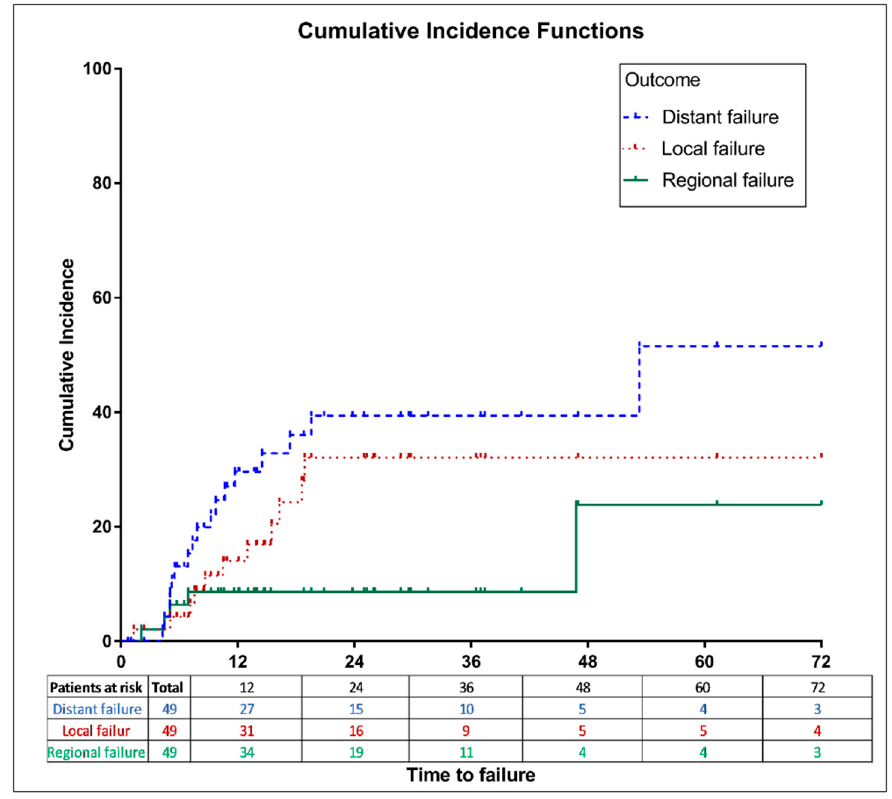
Figure 3. Cumulative incidence method for local, regional, and distant failures in the entire study population.